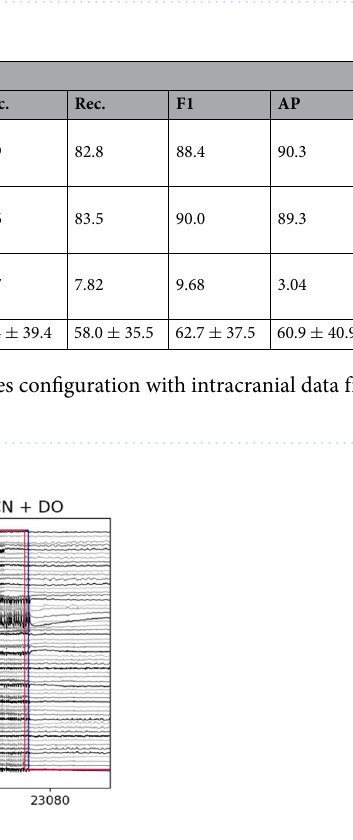
Figure 9. Detections in the evaluation recordings of P8 with the monopolar-intracranial-finetuning setup. The y-axis shows the intracranial electrodes in monopolar configuration, and the x-axis the time in seconds. Blue lines correspond to annotations and red lines to